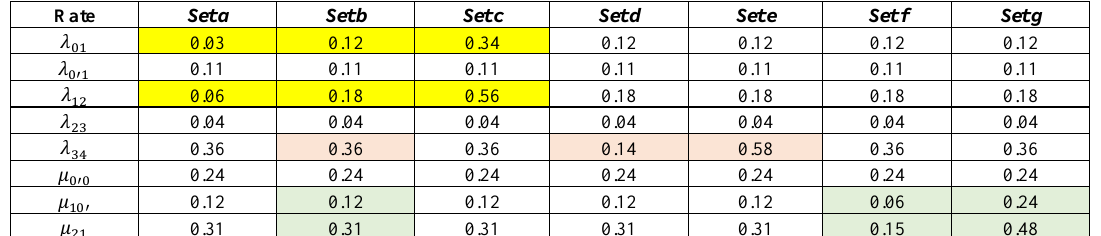
Table 1. State transition rate (per hour) values used for numerical